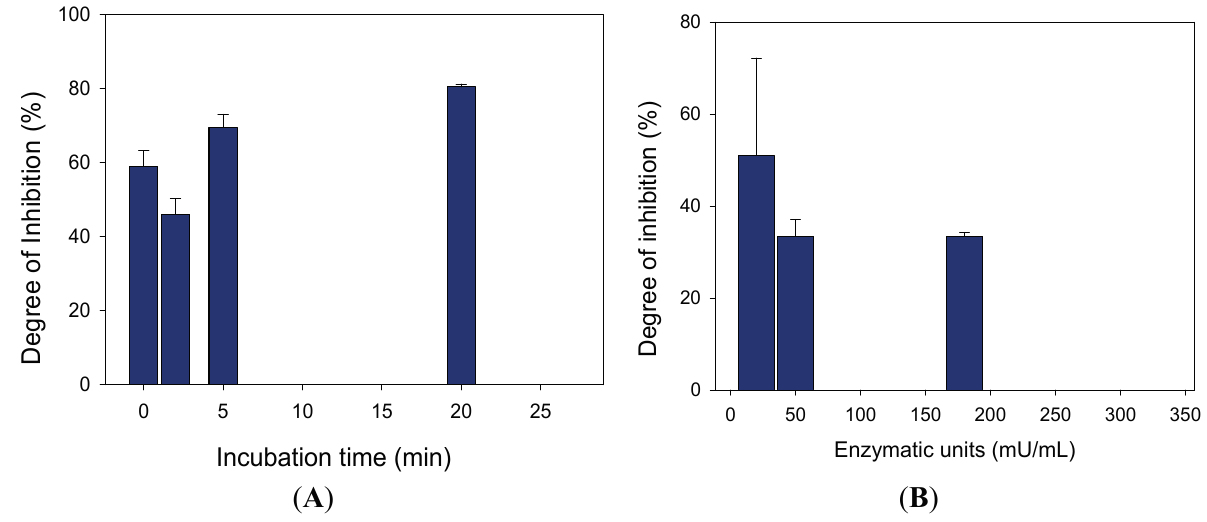
Figure 8. ( A ) Study of percentage inhibition vs. incubation time . Choline oxidase concentration: 180 mU/mL; choline concentration: 0.5 mM; 2-chloroethyl phenyl sulfide concentration: 0.68 mM; Phosphate buffer 0.05 M + 0.1 M KCl, pH 7.4; potential: − 50 mV vs. Ag/AgCl; ( B ) Study of percentage inhibition vs. enzymatic units. Choline concentration: 0.5 mM; 2-chloroethyl phenyl sulfide concentration: 0.68 mM; Phosphate buffer 0.05 M + 0.1 M KCl, pH 7.4; potential: − 50 mV vs. Ag/AgCl; incubation time: 120 s. Measurements were carried out in